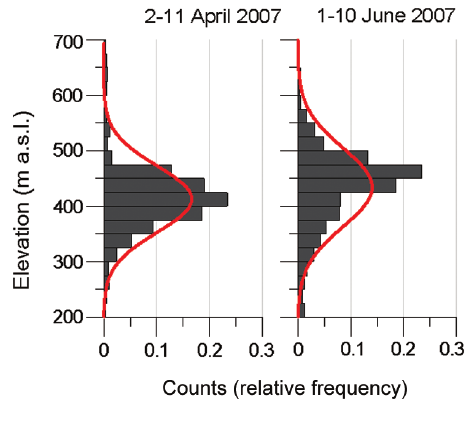
Fig. 17. Comparison of the depth distributions of the VLP hypocenters calculated by radial semblance analysis for two different periods after the end of the effusive eruption. Left : the period of April 2-11, 2007 (2711 VLP events). Right : the period of June 1-10, 2007 (2129 VLP events). Note the increase in the el- evation over the periods considered.